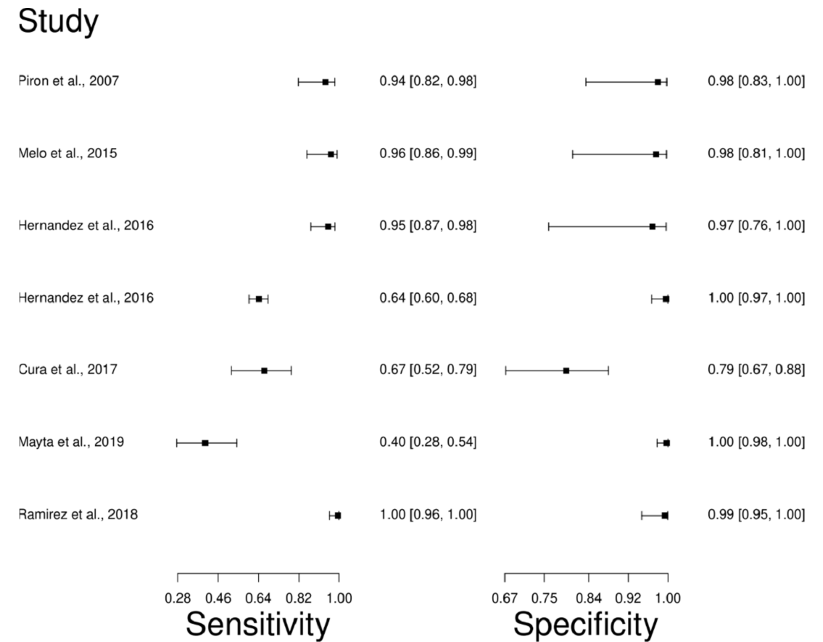
Figure 8. Study data and paired forest plot of the sensitivity and specificity quantitative Polymerase chain reaction (qPCR) in Chagas’s disease diagnosis. Data from each study are summarized. Sensi- tivity and specificity are reported with a mean (95% confidence limits). The Forest plot depicts the estimated sensitivity and specificity (black squares) and its 95% confidence limits (horizontal black line) [27,94,95,97–100].